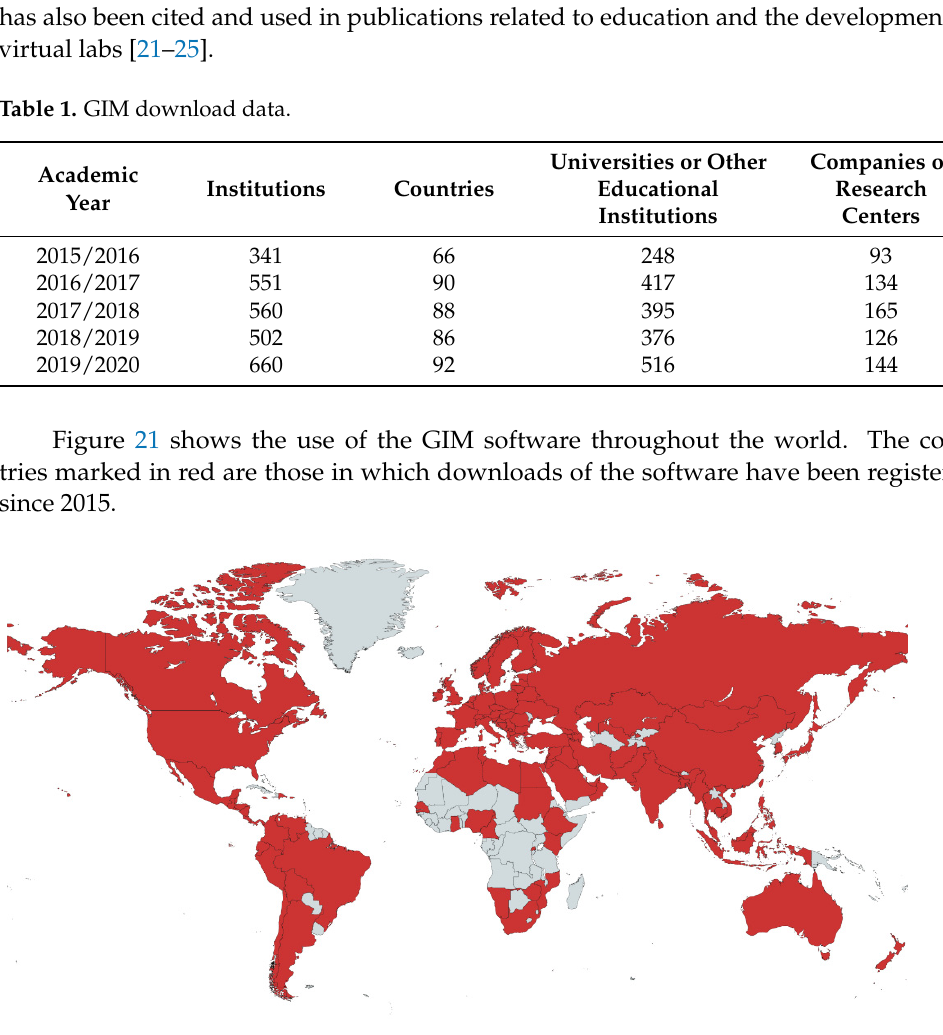
Figure 21. Countries using GIM